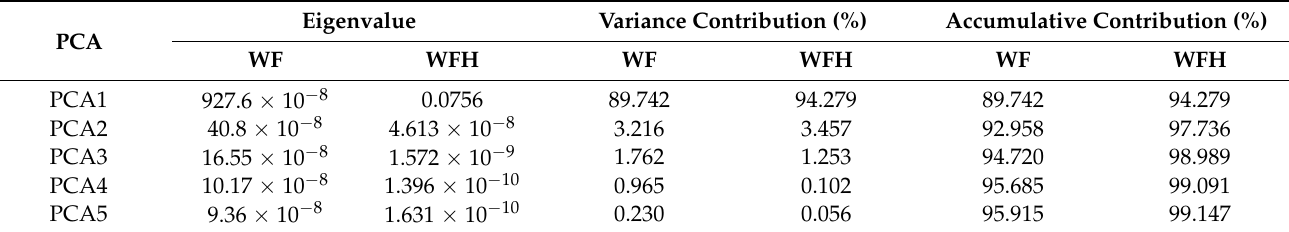
Table 3. The PCA results in eigenvalue and variance contribution rate. Eigenvalue Variance Contribution (%) Accumulative Contribution